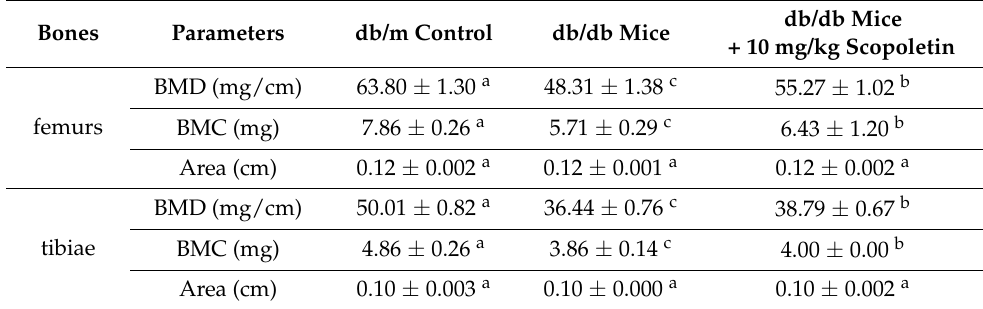
Table 2. Osteogenic activity of scopoletin in db/db